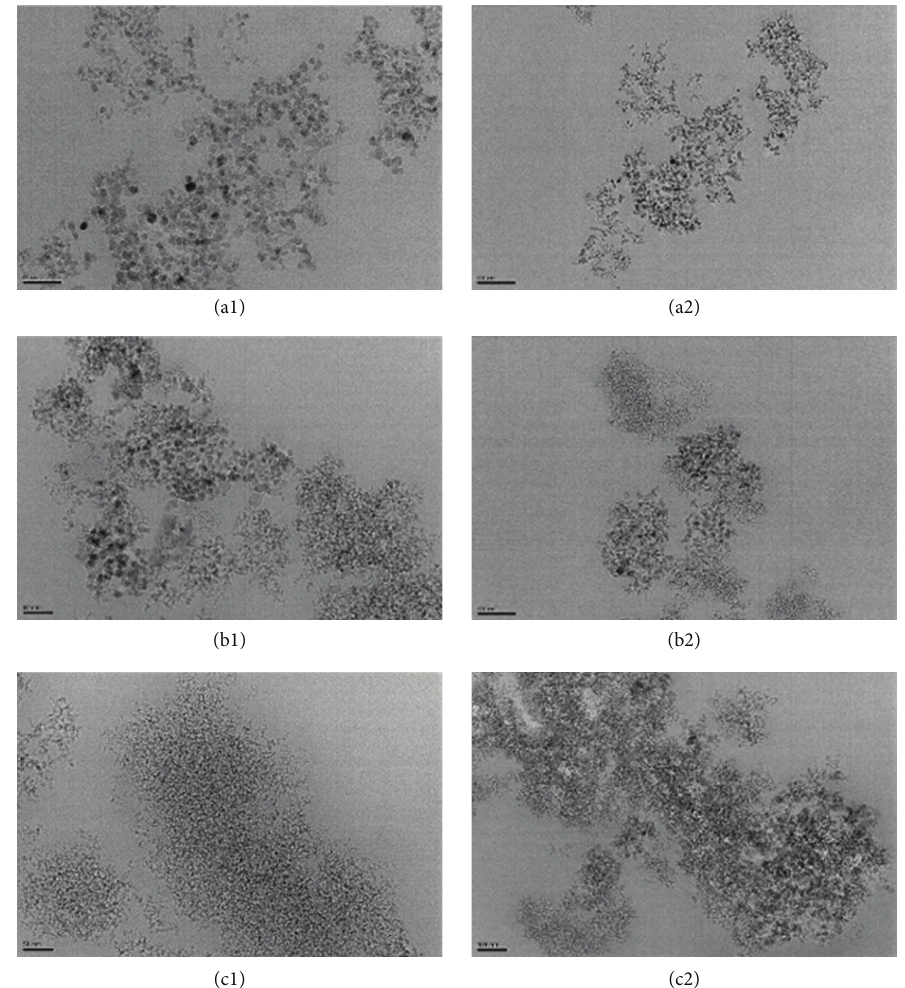
Figure 6: Representative transmission electron microscopy images of the nanodiamonds dispersed in the base material at varying contents: (a) 0.2, (b) 0.5, and (c)